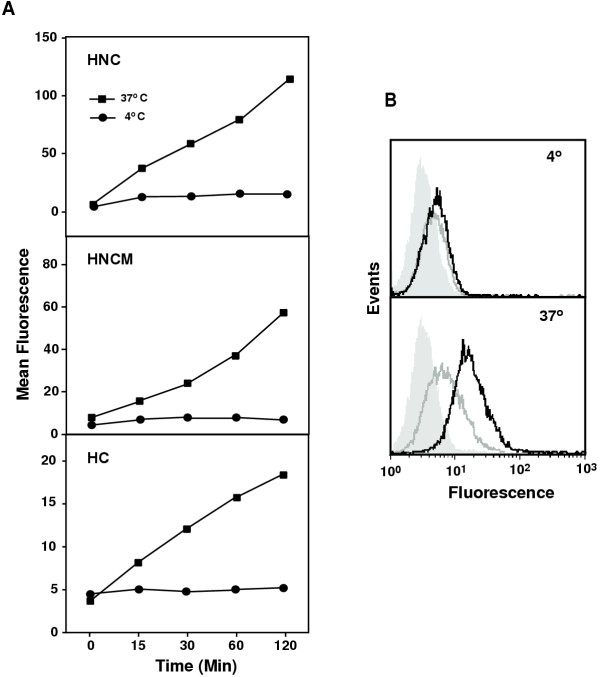
Uptake of fluorescent Cre fusion proteins. Tex.loxp.EG cells were treated for different lengths of time with the indicated Alexa 488-labeled Cre fusion proteins at 4 or 37°C and protein uptake was monitored by flow cytometry. (A) Kinetics of protein uptake. The mean fluorescence of cells treated with Alexa 488-labeled Cre fusion proteins, as calculated by the CellQuest software, increased with time and was inhibited at 4°C. (B) Representative FACS profiles of cells treated with the fluorescent HC protein. Cells were treated with Alexa 488-labeled HNCM at the indicated temperature for 0 (light gray, solid), 15 (medium gray) and 120 min (black) and analyzed by flow cytometry. Profiles of cells treated for 30 and 60 min. have been omitted for clarity.